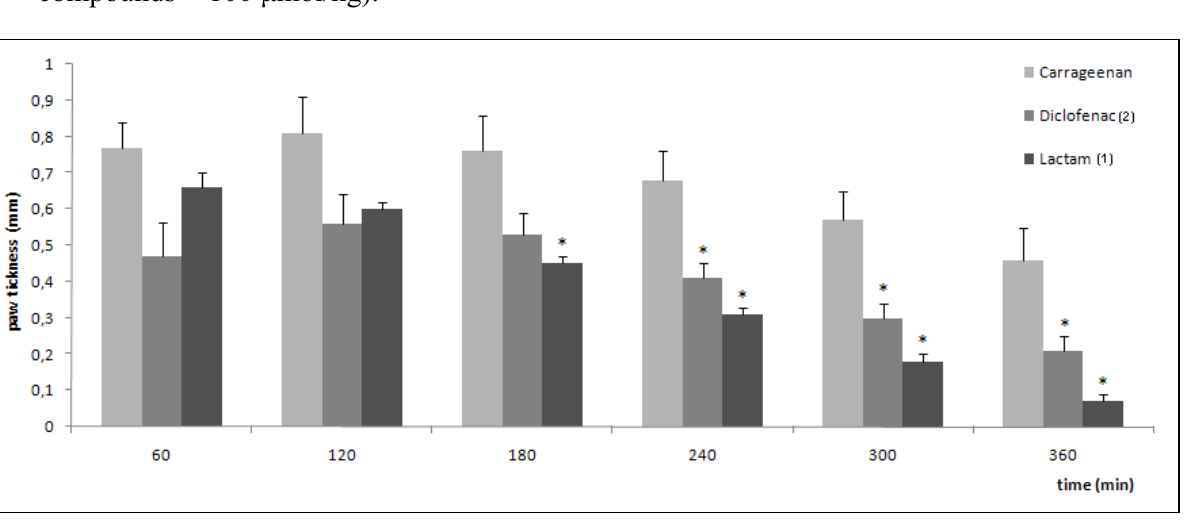
Figure 4. Anti-inflammatory activity in carrageenan-induced paw edema in rats (data are represented as mean ±S.E.M., n = 6, * P < 0.05 with respect to carrageenan; dose of compounds = 100 μ